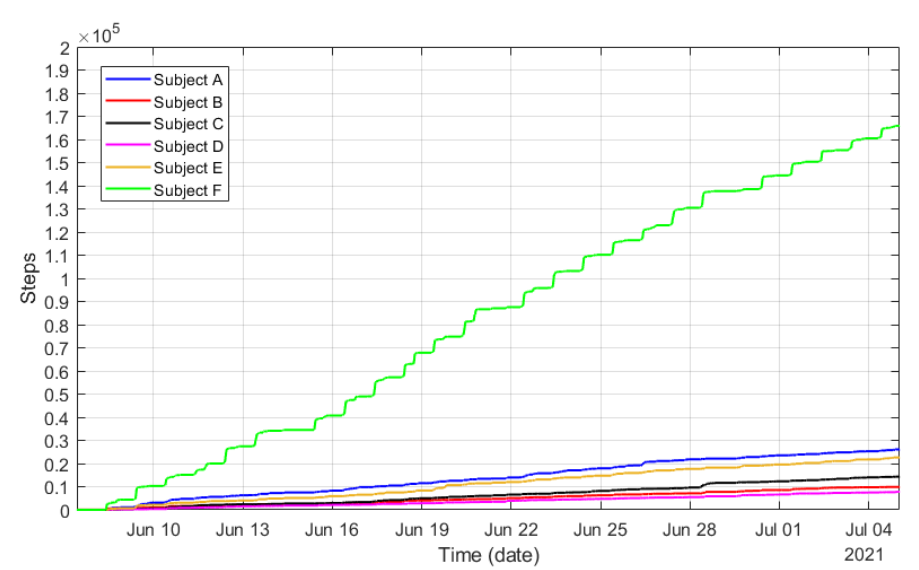
Figure 31. Accumulated steps registered by the wristbands corresponding to the six participants during the preliminary piloting